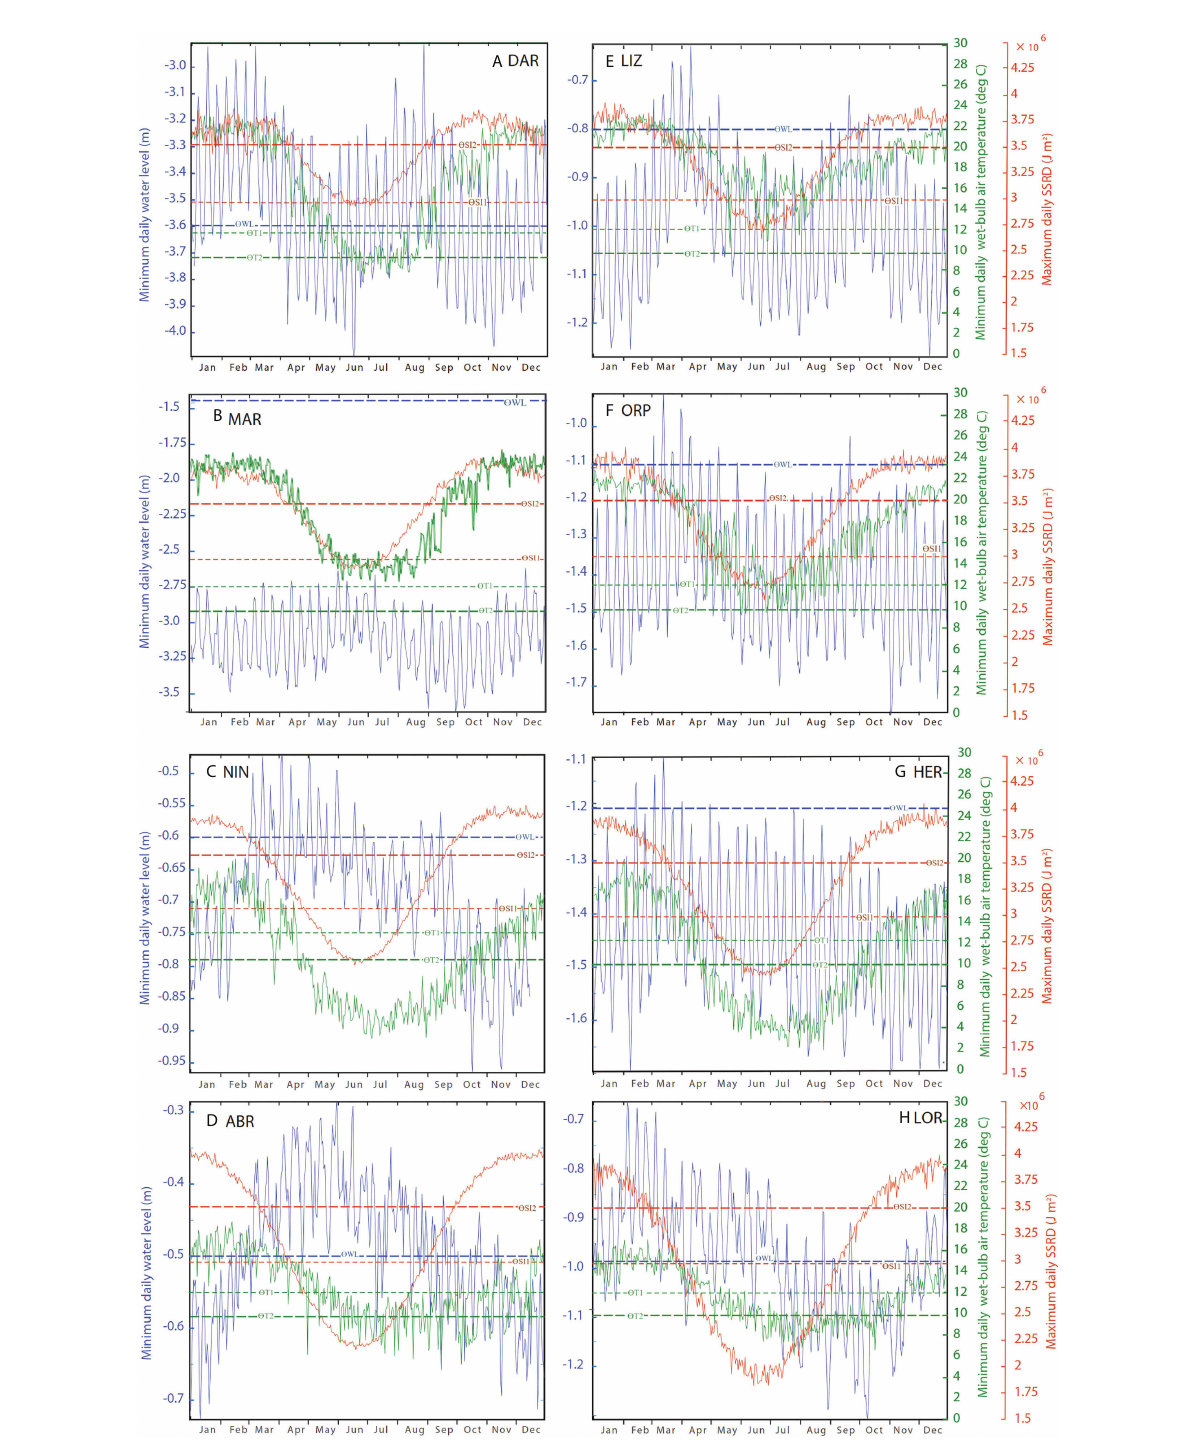
FIGURE 3 Extreme values: for sites (A) Darwin (DAR), (B) Maret Island (MAR), (C) Ningaloo Reef (NIN), (D) Abrolhos Islands (ABR), (E) Lizard Island (LIZ), (F) Orpheus Island (ORP), (G) Heron Island (HER) and (H) Lord Howe Island (LOR) from hourly data for each calendar day over the years 1992- 2016, for minimum water level, blue (http://sealevelx.ems.uwa.edu.au), maximum daily solar irradiance, orange (ECMWF ERA5 atmospheric reanalysis) and minimum atmospheric temperature, green (Bureau of Meteorology wet-bulb temperature observations) per site. Dashed lines show emersion threshold ( Ɵ WL), solar irradiance thresholds ( Ɵ SI 1 and Ɵ SI 2), and temperature thresholds ( Ɵ T w 1 and Ɵ T w